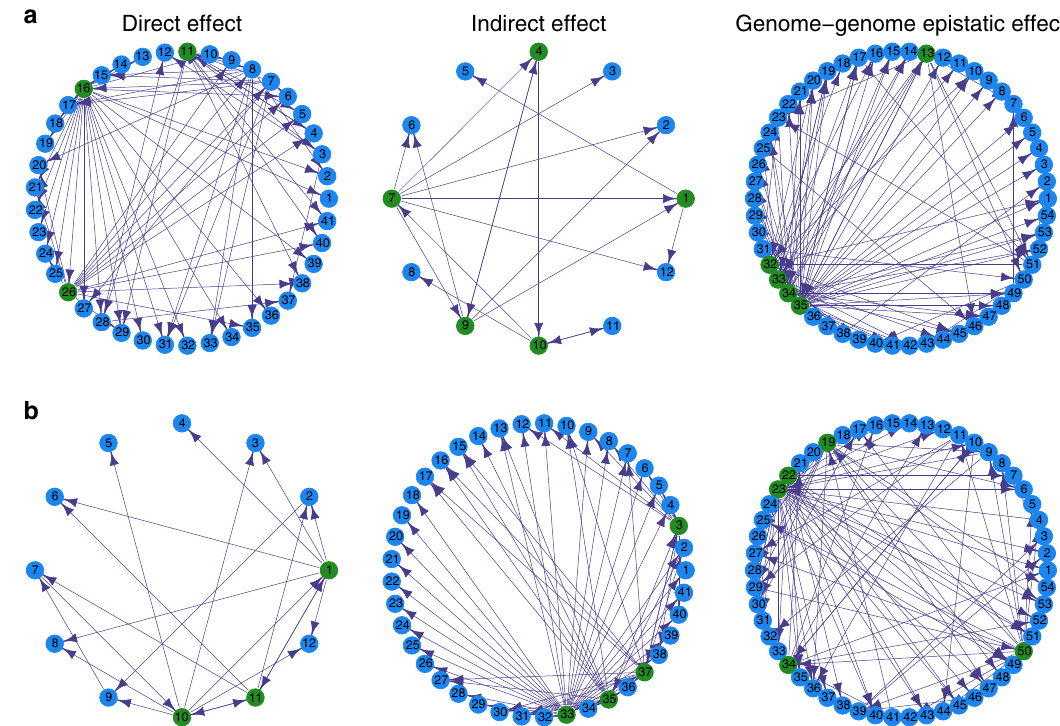
Fig. 5 QTL networks through different types of genetic effects. a Direct effects of 41 E. coli QTLs, indirect effects of 12 S. aureus QTLs, and inter-genomic epistatic effects of these QTLs on the growth trajectory of E. coli . b Direct effects of 12 S. aureus QTLs, indirect effects of 41 E. coli QTLs, and inter-genomic epistatic effects of these QTLs on the growth trajectory of S. aureus . Arrows indicate the direction of one QTL/effect to activate another QTL/effect. Names of genes corresponding to each number are given in Supplementary Table